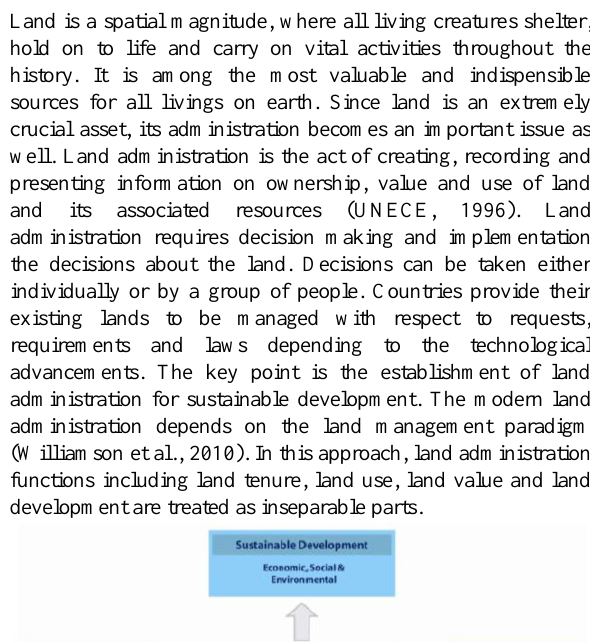
Figure 1. The land management paradigm (Enemark, 2004) Sustainable development consists of economic, social and environmental components and the basis of the paradigm is the Institutional Arrangements depending on the country context. Policies, Land Information Infrastructures and